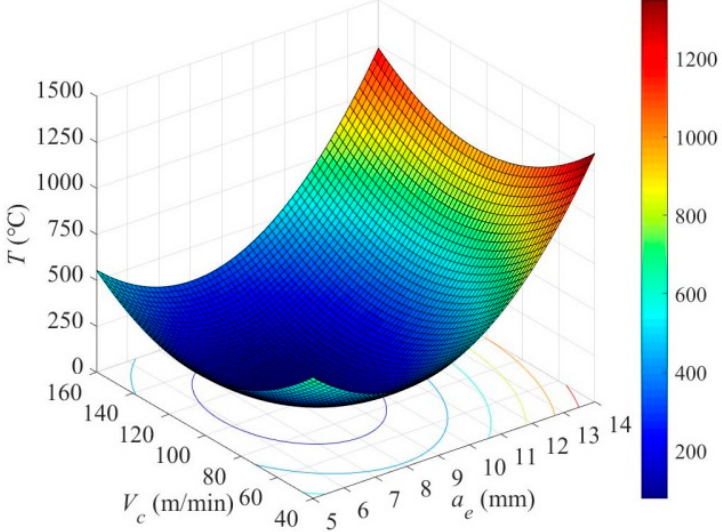
Figure 9. The interaction of a e × V c ( a p = 0.6 mm, f z = 0.06 mm/z) on maximum cutting temperature T .